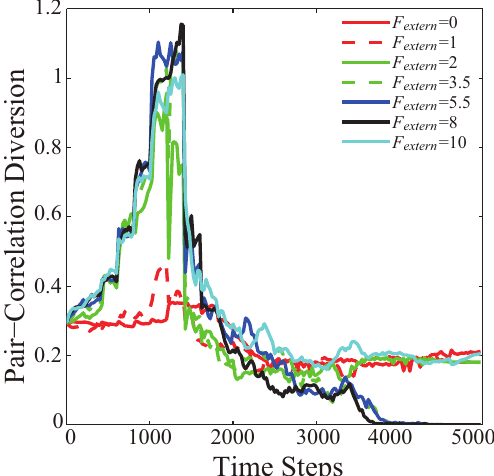
Figure 6. Variation of the PCD curves from VFA-SF-OPT optimization for indicated external central force F extern = 0, 1, 2, 3.5, 5.5, 8 and 10, which correspond to the cases in Table